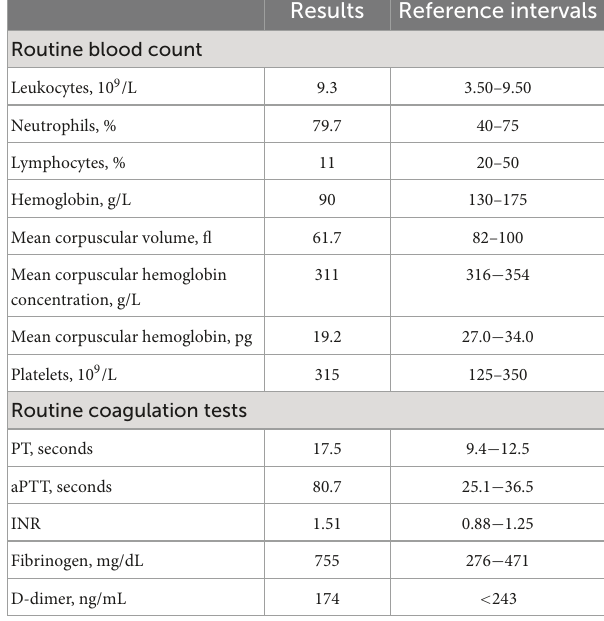
TABLE 1 Results of routine blood count and coagulation tests with abnormal test